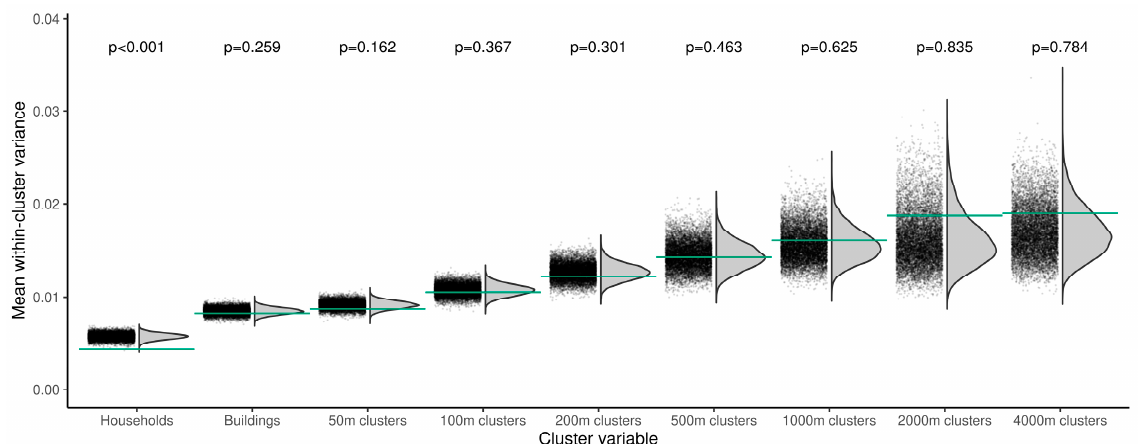
Figure 6. Proximity clustering of Ro-N-Ig test outcomes. We subdivide the participants into disjoint clusters according to various cluster definitions: households, buildings, and spatial clusters of various diameters ( x -axis). For each cluster, we calculated the within-cluster variance of observed Ro-N-Ig test outcomes of all participants in the cluster. Their means over all clusters are marked by green horizontal lines for each cluster size. We then performed 10,000 random permutations of measurements assignments. The black dots show the respective mean within-cluster variances, along with density estimates as grey curves. For buildings and spatial clusters, measurements of a household were only permuted with measurements of a household of the same size. p -values indicate the one-sided probability of a random value being smaller than or equal to the observed one.